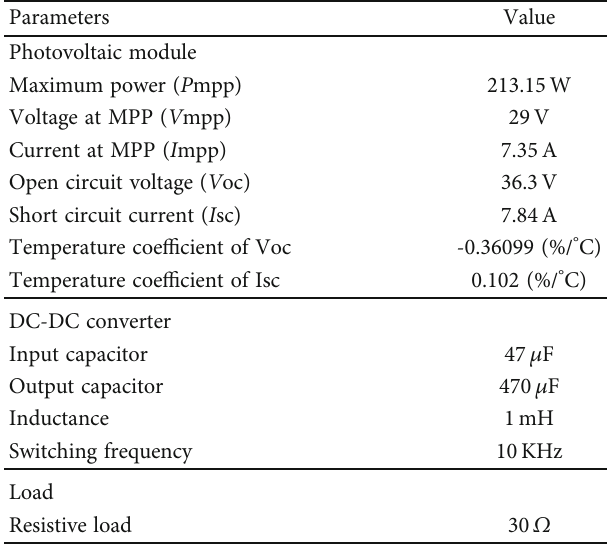
Table 1: Parameters of the 1soltech 1sth-215-p photovoltaic module at STC, DC-DC boost converter, and